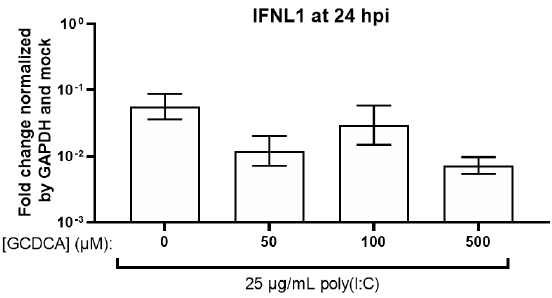
Figure 8. GCDCA in combination with poly(I:C) treatment of HIEs does not induce a greater type III IFN response. Jejunal HIEs were treated with 25 µg/mL poly(I:C) and increasing concentrations of GCDCA. At 24 h post treatment, mRNA levels of IFNL1 (shown), IFNL2 , and IFNL3 were as- sayed. Previously unpublished data. Poly(I:C) treatment of HIEs and RT-qPCR for mRNA levels of type III IFNs performed as in Lin et al., 2020